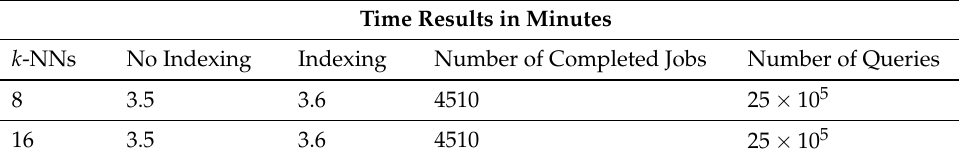
Table 8. Time for 500 Mobile Objects without Indexing and with R -Tree Indexing.